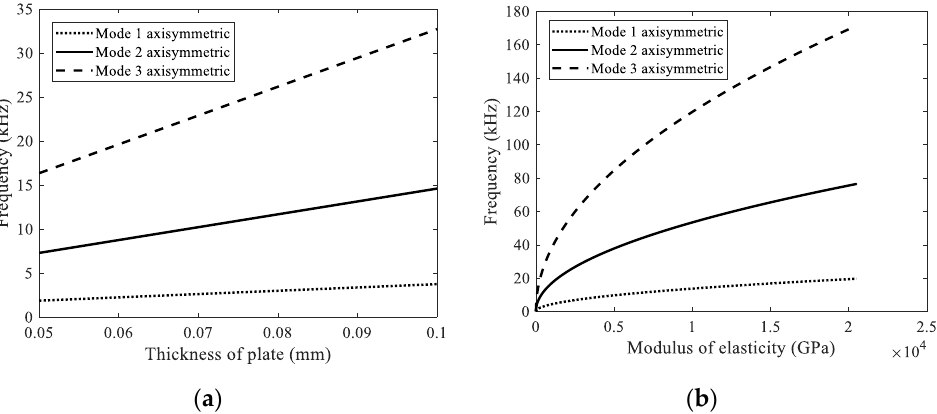
Figure 2. Frequencies calculated as a function of ( a ) the plate thickness and ( b ) Young’s modulus for the first three axisymmetric modes. the first three axisymmetric